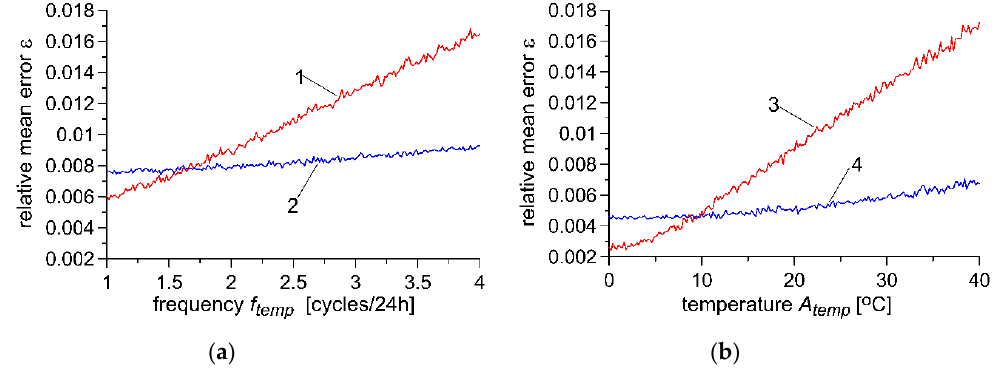
Figure 8. Impact of ( a ) frequency 𝑓 𝑡𝑒𝑚𝑝 of temperature fluctuation on weighing error for autocalibration algorithm parameters optimised, respectively, for 1 − 𝑓 𝑡𝑒𝑚𝑝 = 1[cycles/24h] , 2 − 𝑓 𝑡𝑒𝑚𝑝 = 4[cycles/24h] as well as the impact of ( b ) the amplitude of 𝐴 𝑡𝑒𝑚𝑝 temperature change on weighing error for autocalibration algorithm parameters optimised, respectively, for 3 − 𝐴 𝑡𝑒𝑚𝑝 = 5 °C, 4 − 𝐴 𝑡𝑒𝑚𝑝 =30 °C.